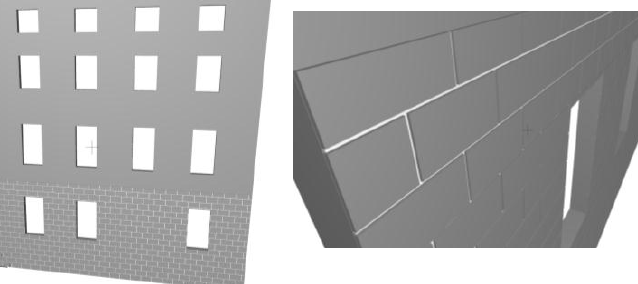
Figure 12. Parametric façade with classically proportioned window openings and block wall detail.